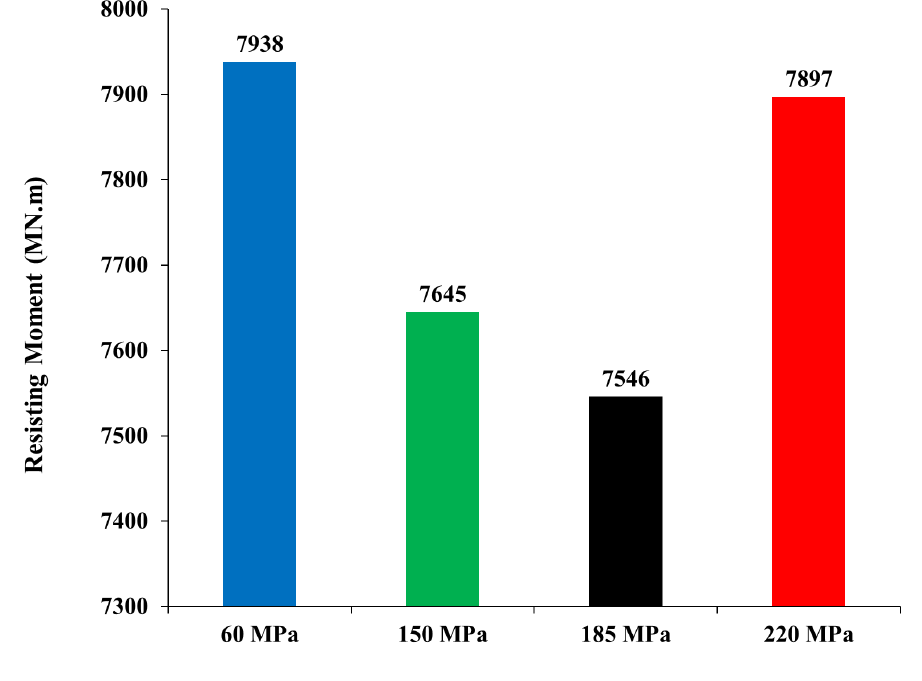
Figure 5. Resisting moment.